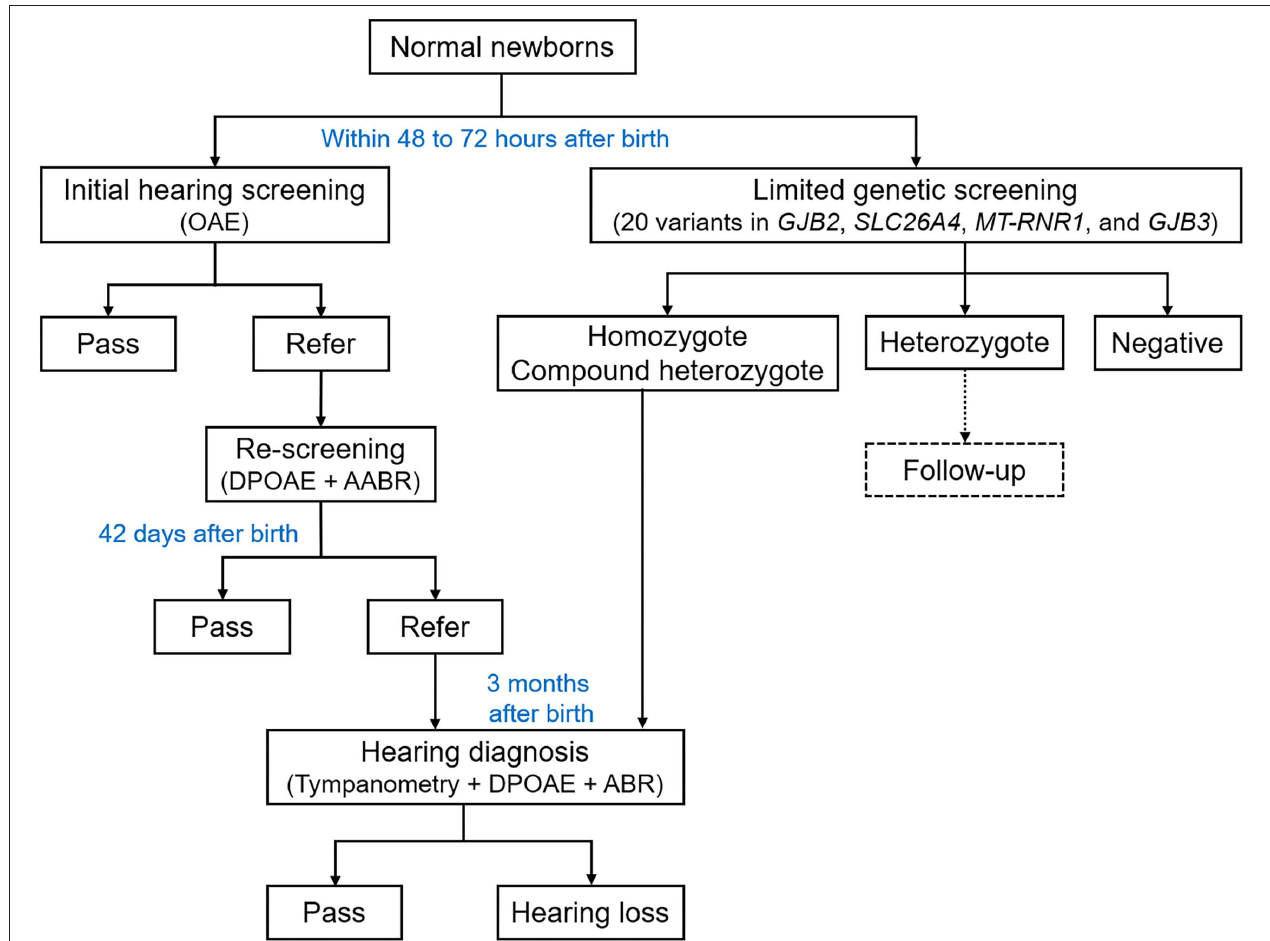
FIGURE 1 | Overall flowchart of the concurrent hearing and genetic study. OAE, otoacoustic emission; DPOAE, distortion product otoacoustic emission; AABR, automated auditory brainstem response; ABR, auditory brainstem